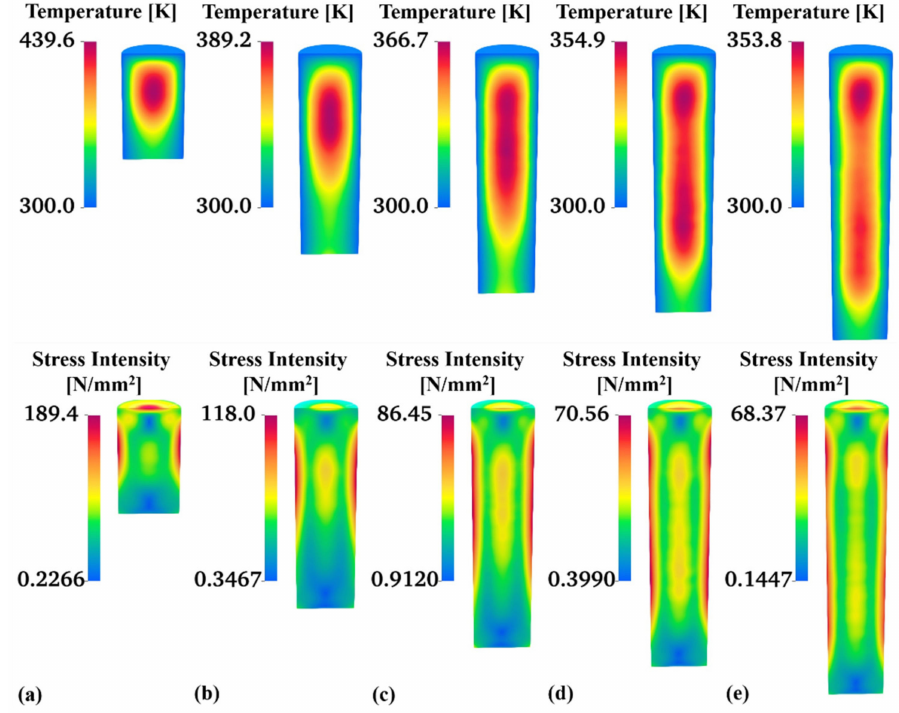
Figure 10. Numerically calculated temperature and stress distributions in Nd:YAG rods in the different optimized solar-pumped laser systems: ( a ) System 1; ( b ) System 2; ( c ) System 3; ( d ) System 4; ( e ) System 5. Table 5. Output laser performance parameters for different optimized SPL systems. System